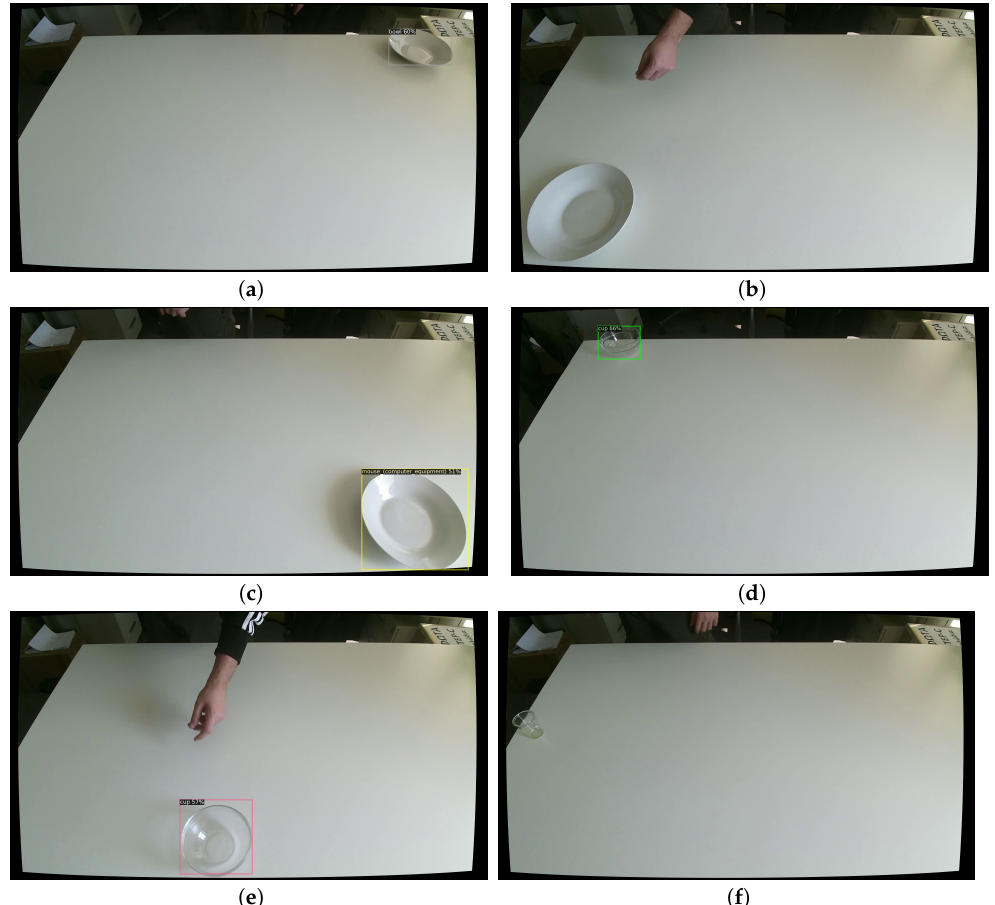
Figure 16. Performance of the off-the-self detector in three classes: ( a , d , e ) show that detector mismatched the classes, ( b , f ) show that the detector did not achieve any detection of object for the plate and the plastic cup. In ( c ) the detector misrecognized the object as a computer mouse rather than as a